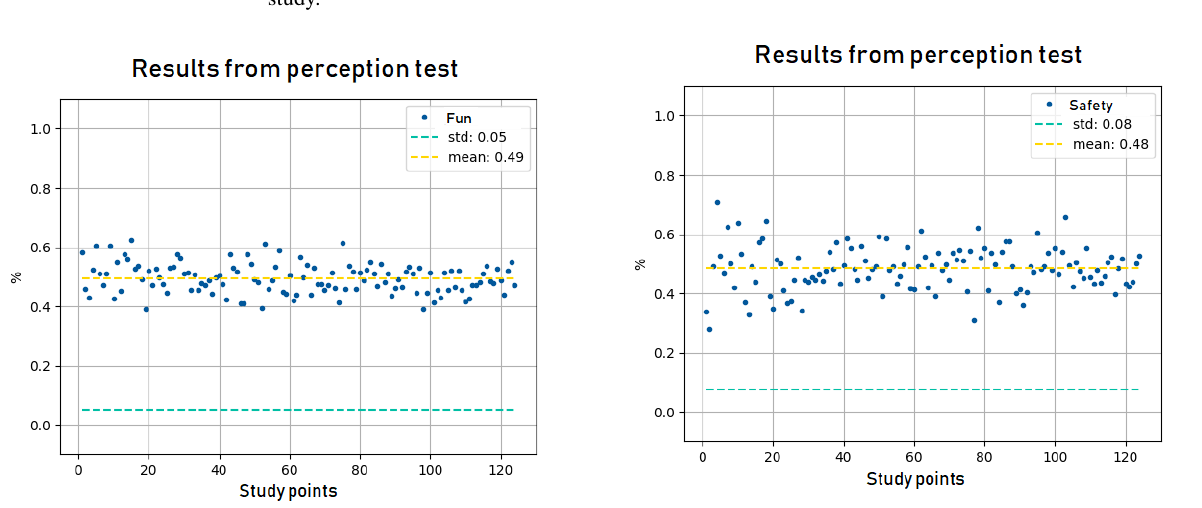
Figure 9. Wealth perceived from the points of study.